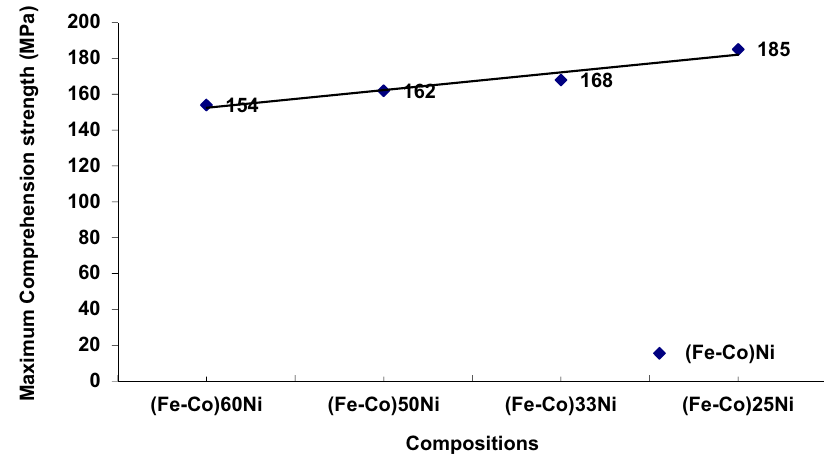
Figure 4: Comprehension strength – composition temperature curve in